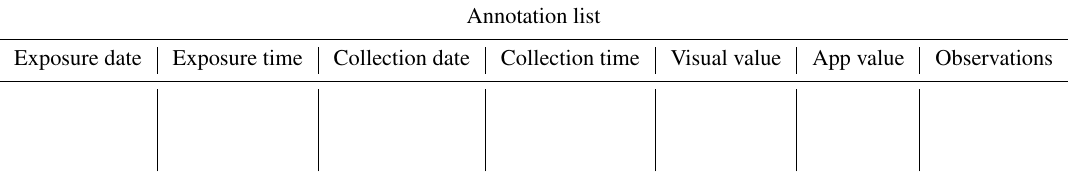
Table 1. Annotation list.